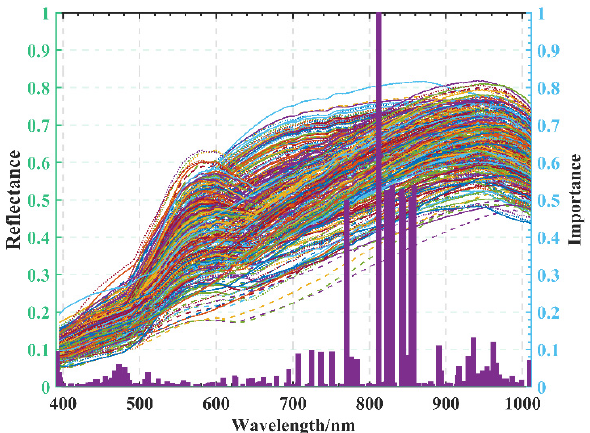
Figure 8. Spectral features are important.